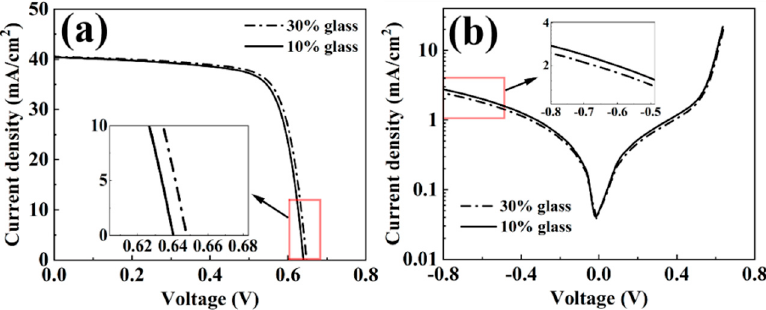
Figure 11. ( a , b ) Light and dark J-V curves of the cells with 10% and 30% solid glass frit in the glass pastes.